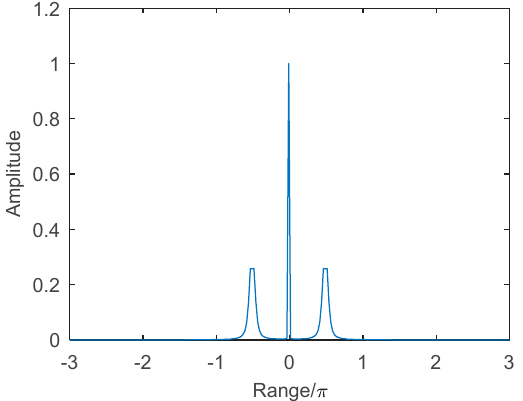
Figure 2. The spectrum of square of Bessel function.